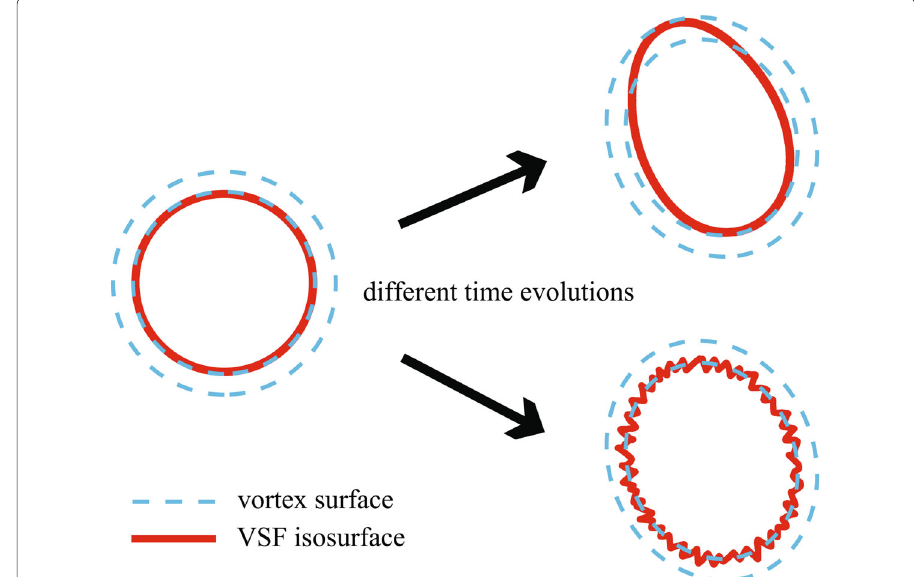
Fig. 4 Sketch of different surface tracking performances from a given time t (left) to a later time t + (cid:11) t (right). The blue dashed loops denote two vortex surfaces in the ideal tracking, and red solid loops denote a VSF isosurface from a numerical VSF solution. The upper right solution has satisfactory accuracy but poor Lagrangian tracking performance, and the bottom right one has poor accuracy but satisfactory tracking